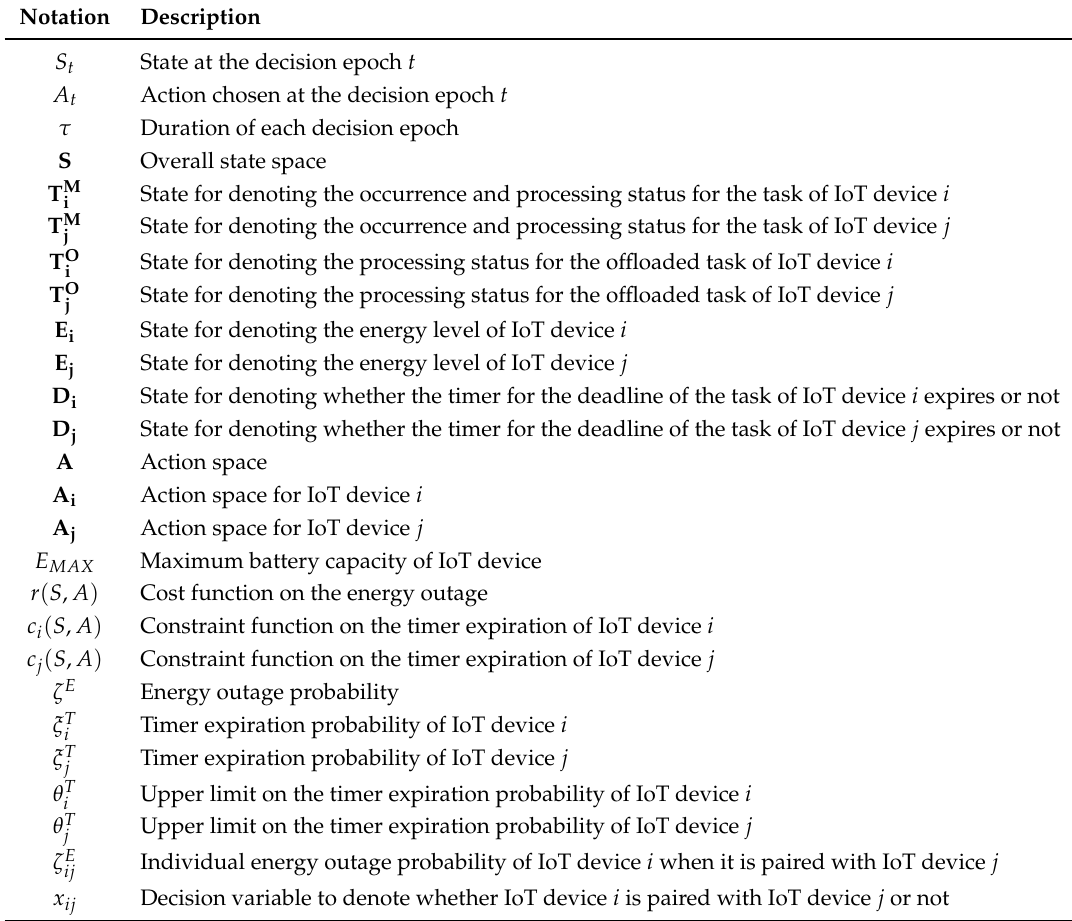
Table 1. Summary of notations.